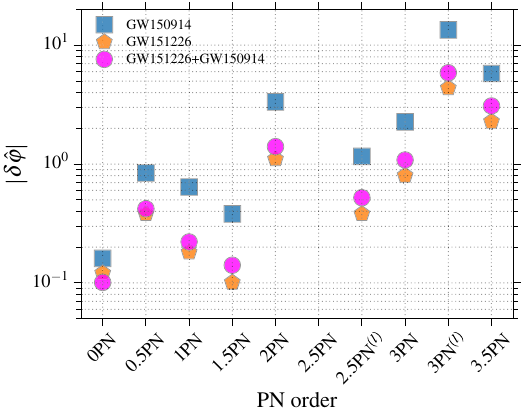
FIG. 1. This is the corrected Fig. 8 of [4], showing the 90% credible upper bounds on deviations in the PN coefficients from GW150914, from GW151226 and from both. It also fixes a previous plotting error for the 0 PN individual bounds (the GW150914 and GW151226 bounds were incorrectly drawn on top of